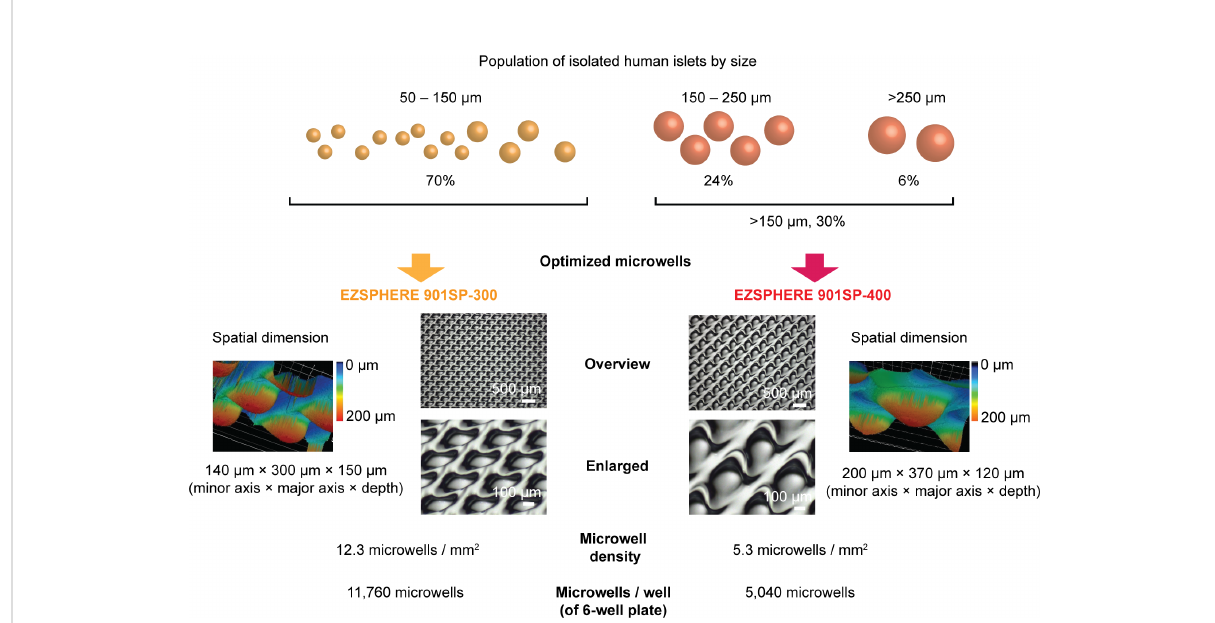
FIGURE 3 Strategy to culture various-sized human islets using two different-sized microwells. Islet size distribution was obtained from 48 human islet isolations, demonstrated in our previous study; ~70% of islets were 50 – 150 µm in diameter and ~30% in >150 µm. EZSPHERE 901SP-300 (140 µm [minor axis] × 300 µm [major axis]) was used for 50 – 150 µm-islets. EZSPHERE 901SP-400 (200 µm [minor axis] × 370 µm [major axis]) was used for >150 µm-islets. Microscopic laser scanning 3D (inverted image of microwells) and 2D bright- fi eld images are